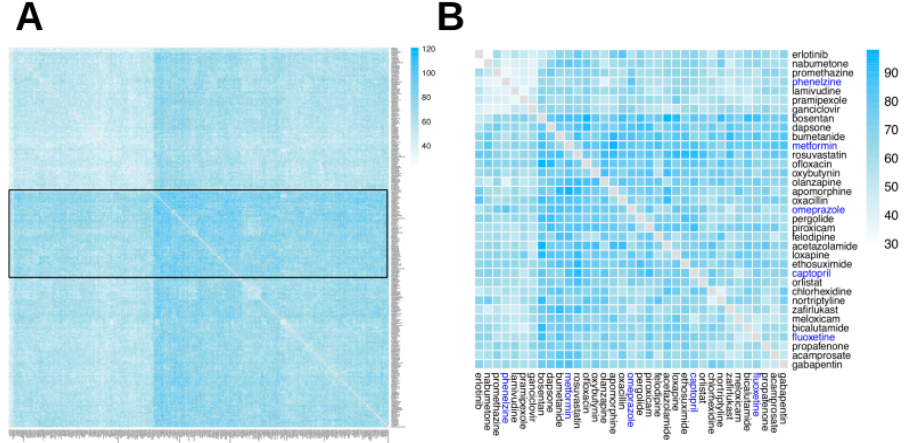
Figure 5. Heatmap of two-drug combination cADRs via mode 2 configuration. The mode 2 configuration indicates that each drug in the combination may perturb a different GO term that is associated with cADR manifestation. The heatmap is organized using a hierarchical clustering. It can be seen that most of most drug pairs exhibit a large number of mode 2 configurations. ( A ) The complete heatmap, containing all 315 drugs; a band of drugs with the most mode 2 configurations is shown (inside the solid line rectangle). ( B ) A subset of the heatmap, containing 35 drugs: five drugs highlighted in blue, which are used in examples in the Discussion section, and the six drugs most similar to each of them (in terms of number of instances of mode 2 configurations) from Panel A.